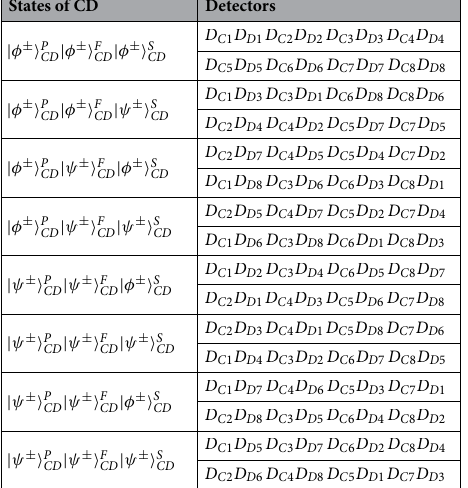
State of AB Half-wave plates